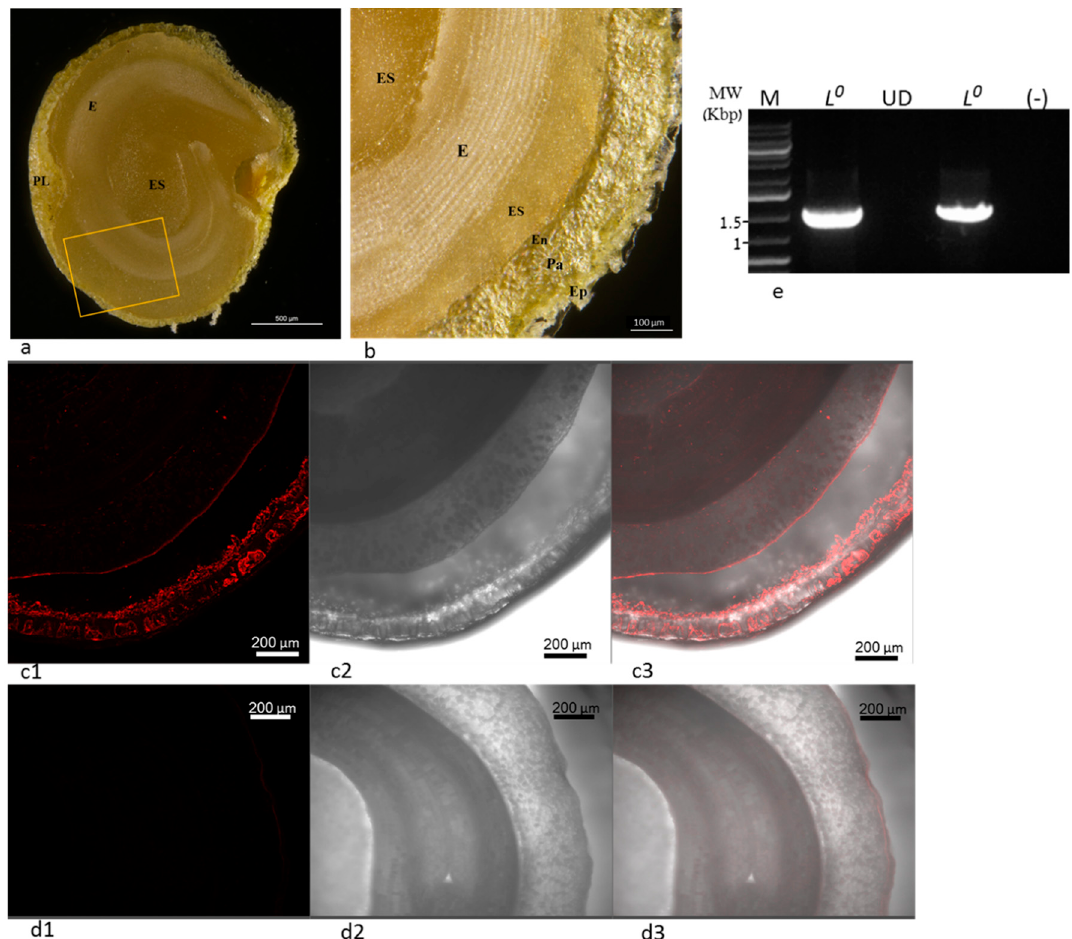
Figure 7. ToBRFV in seeds of systemically infected L 0 cv. 6210 plants were not restricted to epidermis surface but localized in the maternal parenchyma and endothelium: ( a ) a bright light image of a longitudinal dissected seed; ( b ) higher magnification of the area marked by a box in ( a ); ( c1 – c3 ) seeds of ToBRFV foliar-inoculated L 0 cv. 6210 ( d1 – d3 ); seeds of ToBRFV foliar-inoculated L 1 cv. Lapid serving as a negative control for ToBRFV seed infection; ( c1 , d1 ) a red channel showing ToBRFV in the epidermis, parenchyma, and endothelium not entering the endosperm of L 0 cv. 6210 plants and not in L 1 cv. Lapid plants (the same setting used for the two images); ( c2 , d2 ) a transmitted light image; ( c3 , d3 ) merging transmitted and red channel images; ( e ) RT-PCR showing the presence of 1122 ToBRFV amplicon in seeds of leaf- and root-inoculated L 0 cv. 6210 plants using primer set number (5); Ep, epidermis; Pa parenchyma; En, endothelium; ES, endosperm; E, embryo.